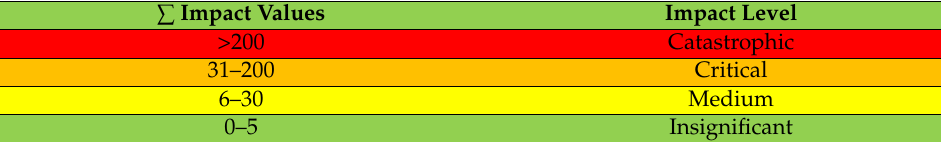
Table 21. Cybersecurity: impact levels.